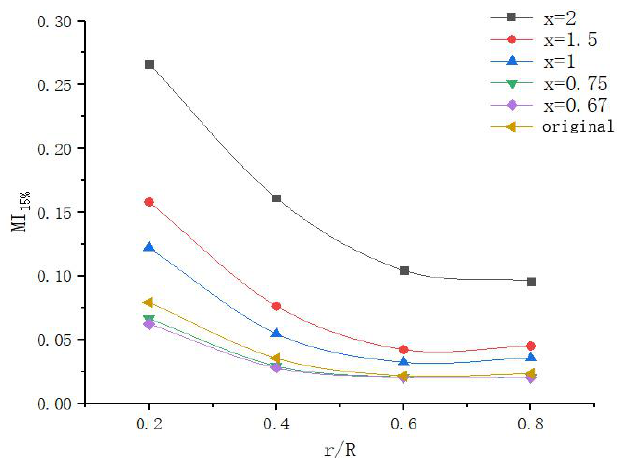
Figure 13. Influence of different scale-up criteria on the MI curve with 10% solid volume fraction.